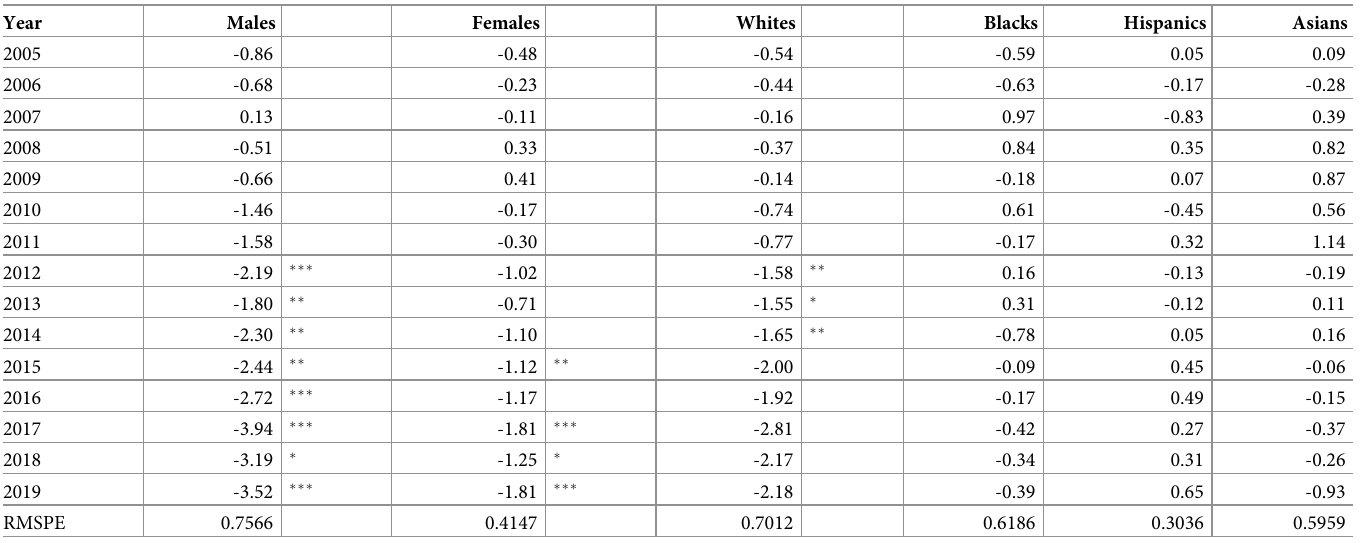
RMSPE The effect is the reduction in mortality rate (deaths per 100,000 persons) �